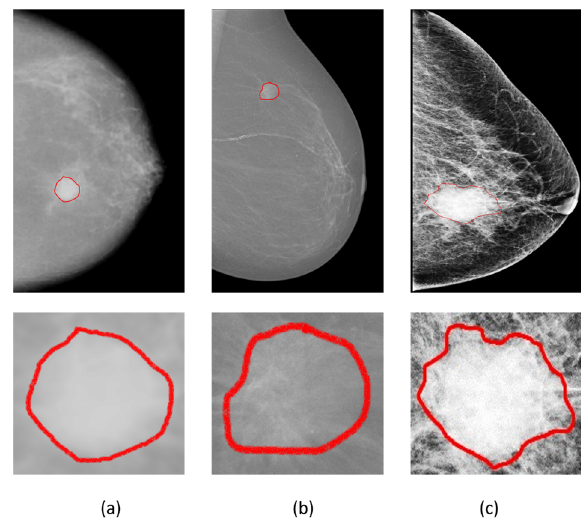
Fig. 10 Samples from the public and private mammography datasets with zoomed-in ROI of mass ground truth (red). a CBIS- DDSM mammogram example of MLO view. b INbreast mammogram example of MLO view. c Private mammogram of CC view.